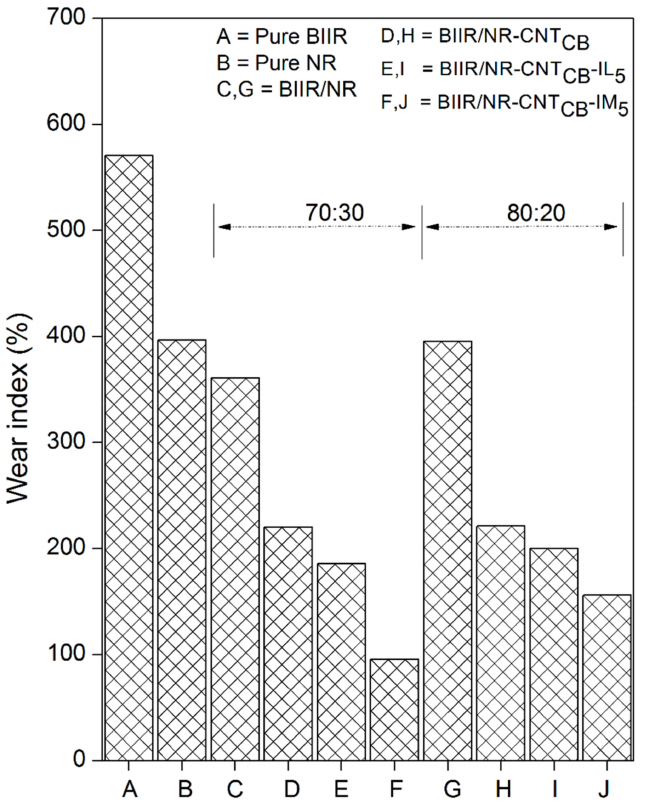
Figure 14. Wear index of pure rubbers and their composites with and without IL and IM modifiers, BIIR:NR ratios of 70:30 and